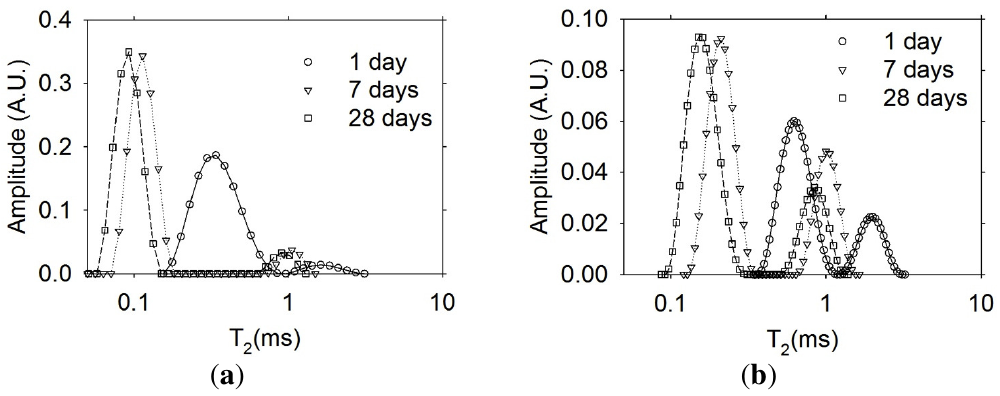
Figure 10. Inverse Laplace Transformation of the transverse magnetization decay measured with the embedded sensors in concrete ( a ) w/c ratio = 0.30; and ( b ) w/c =